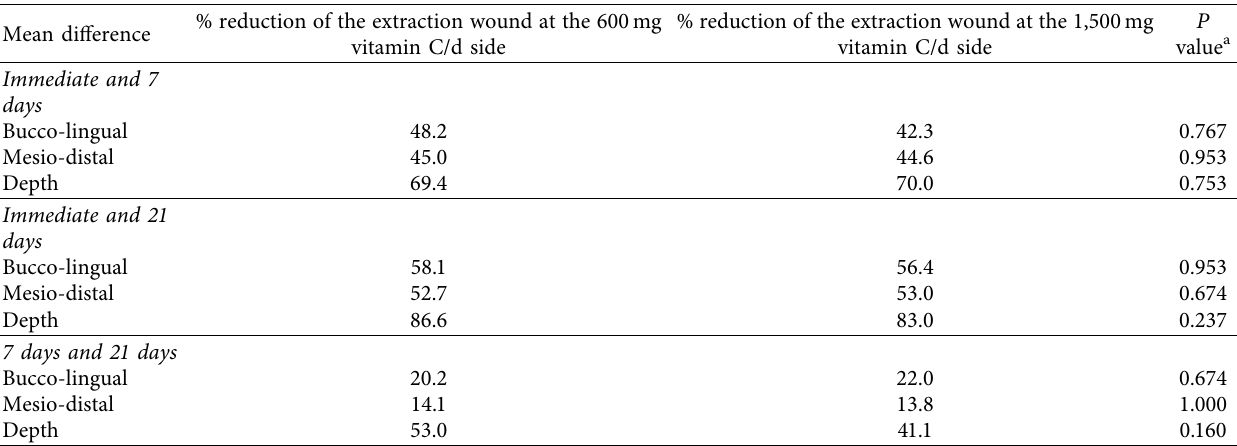
Table 3: % reduction in mean wound size between the 2 extraction sites in the 600/1,500 group (600mg vitamin C/d vs.1,500mg vitamin C/d). % reduction of the extraction wound at the 600mg % reduction of the extraction wound at the 1,500mg Mean difference vitamin C/d side vitamin C/d